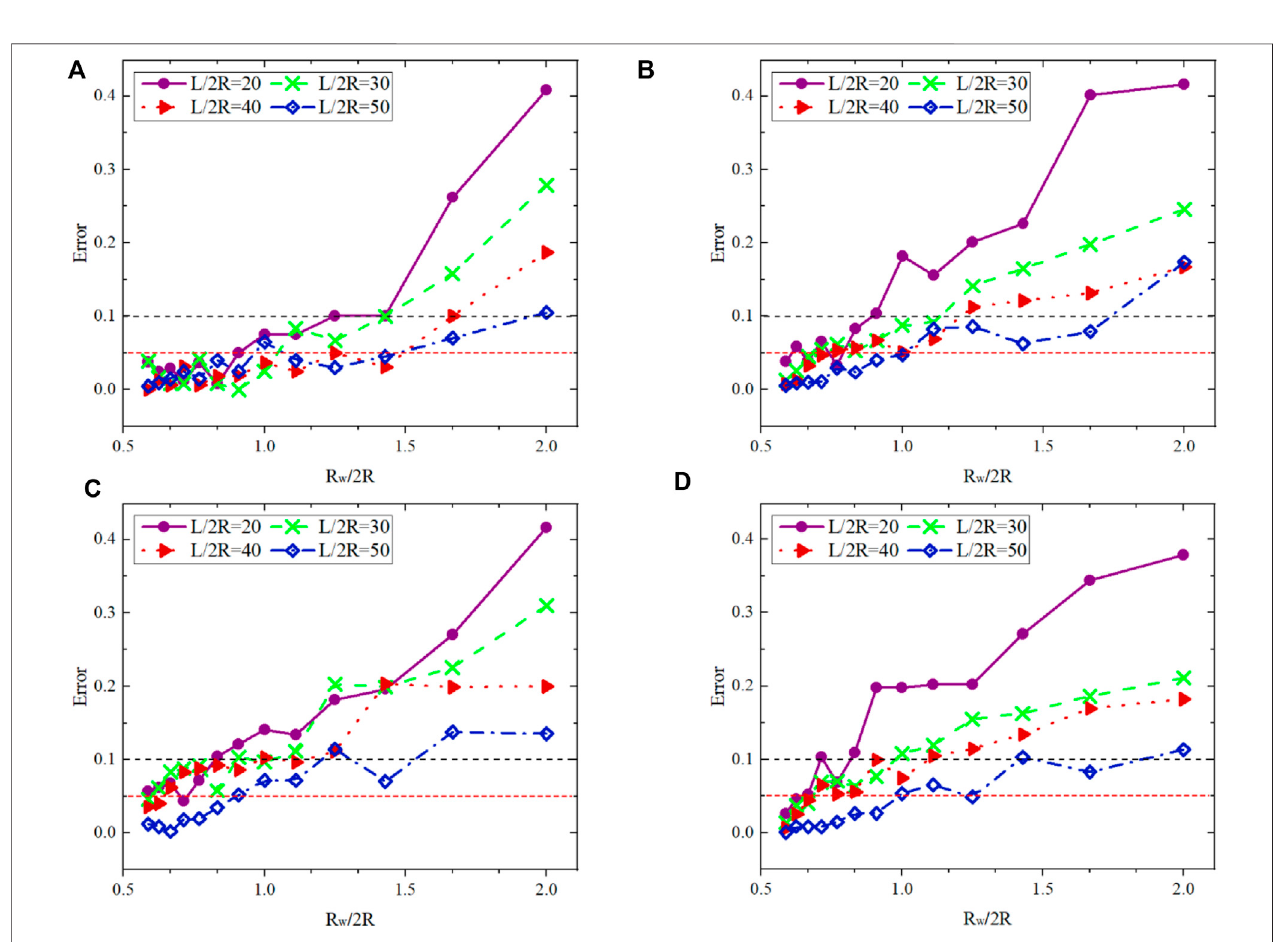
FIGURE 7 | Errors of estimated and realistic crack lengths vs. dimensionless parameter for four different dip angles in the single crack DEM-DFN model. (A) 0 ° single-crack measurement error. (B) 15 ° single-crack measurement error. (C) 30 ° single-crack measurement error. (D) 45 ° single-crack measurement error.